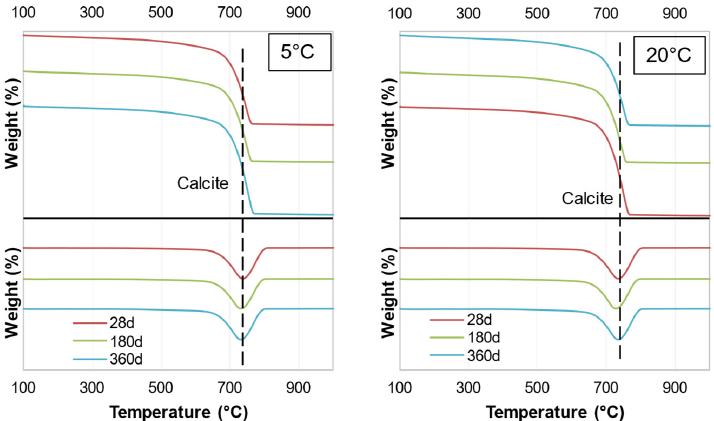
Figure A6. TGA results of S + F + W3.